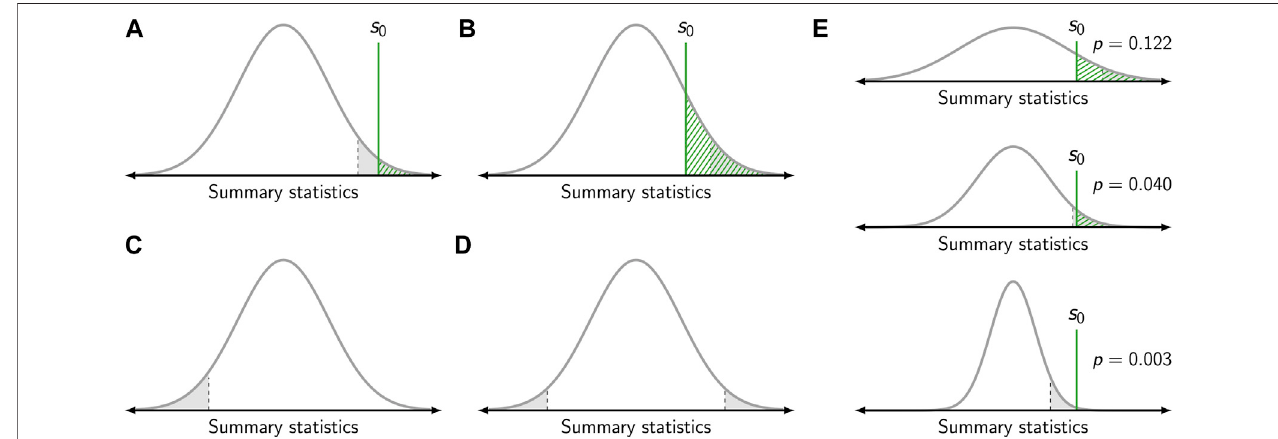
FIGURE 3 | Calculation of the p -value. (A,B) Gray curves show the sampling distribution of the summary statistic under the null hypothesis. The value of the summary statistic s 0 obtained for one speci fi c sample is shown as green vertical line. The p -value corresponds to the dashed green area. The gray area corresponds to the level of signi fi cance, which was set to α = 0.05. If the p -value falls below the level of signi fi cance (i.e., s 0 falls within the gray area), the null hypothesis is rejected (A) . Otherwise, the null hypothesis is kept (B) . In panels (A) and (B) a right-sided test is depicted. (C) Left-sided test. (D) Two-sided test. (E) In fl uence of sample size. The same value s 0 of the summary statistics yields a different p -value dependent on the sample size (top to bottom). For a smallsample size, the sampling distribution is broad and the null hypothesis is kept (top). For a large sample size, the sampling distribution is narrow and the null hypothesis is rejected